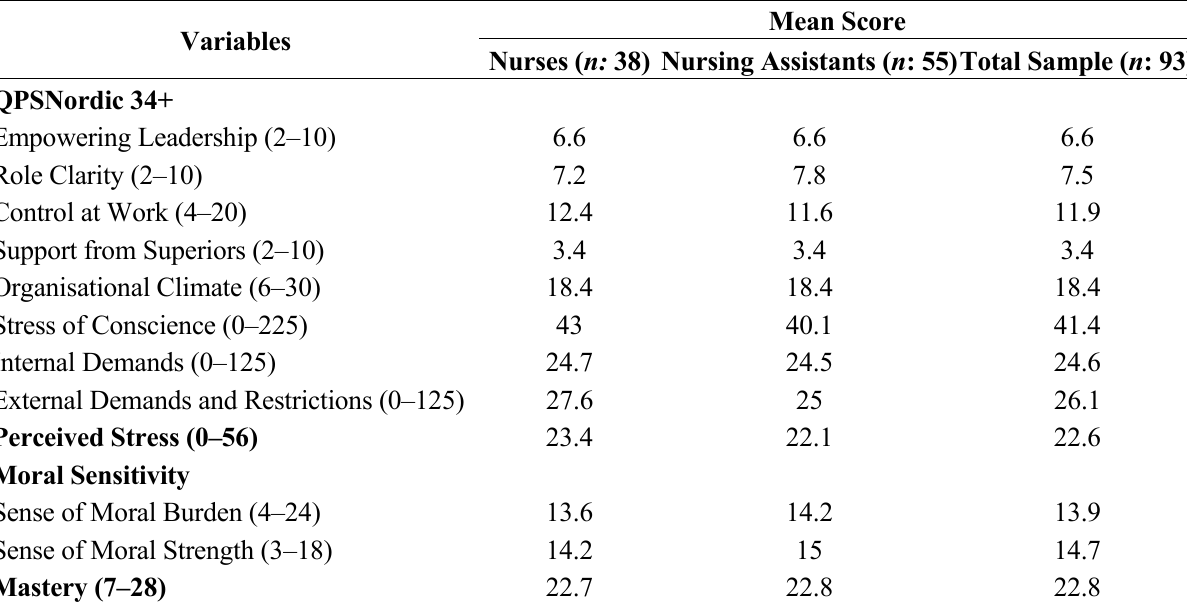
Table 1. Mean values for the QPSNordic 34+, Stress of Conscience Questionnaire, Perceived Stress Scale, Moral Sensitivity Questionnaire, and Mastery